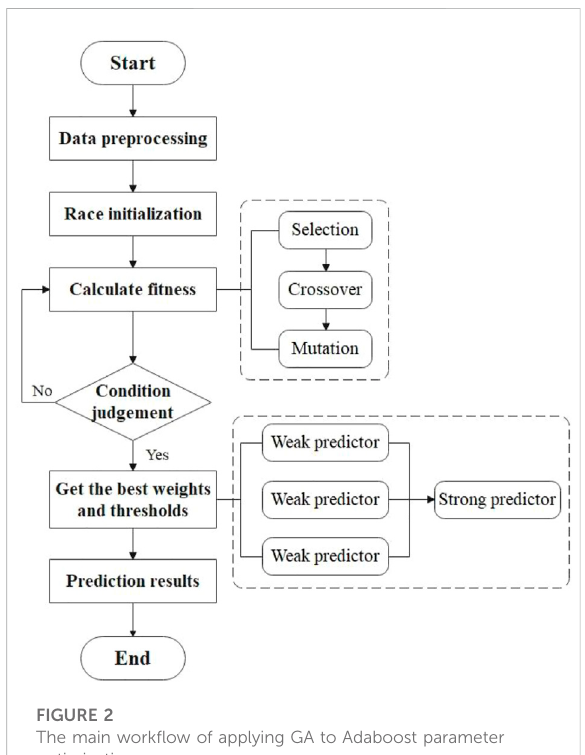
FIGURE 2 The main work fl ow of applying GA to Adaboost parameter